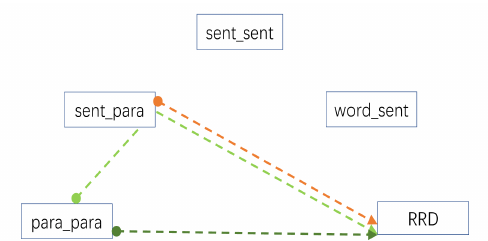
Figure 11. Results of a path analysis showing the significant patterns of influence (p < 0.05) of the four similarity measures used in the analysis of RRD for good readers. Distinct paths are illustrated with different colours, where the start of the path is represented by a filled circle and its end by an arrowhead. Dashed paths indicate a negative estimate and a reduction in viewing time, solid lines are positive estimates that contribute to an increase in viewing